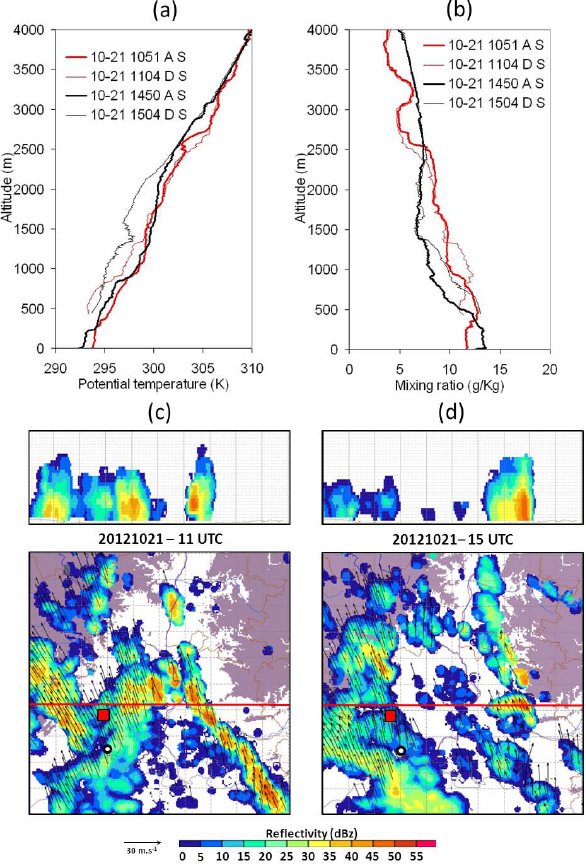
Fig. 10. As in Fig. 9, but for the 21 October 2012 at 12:00 and